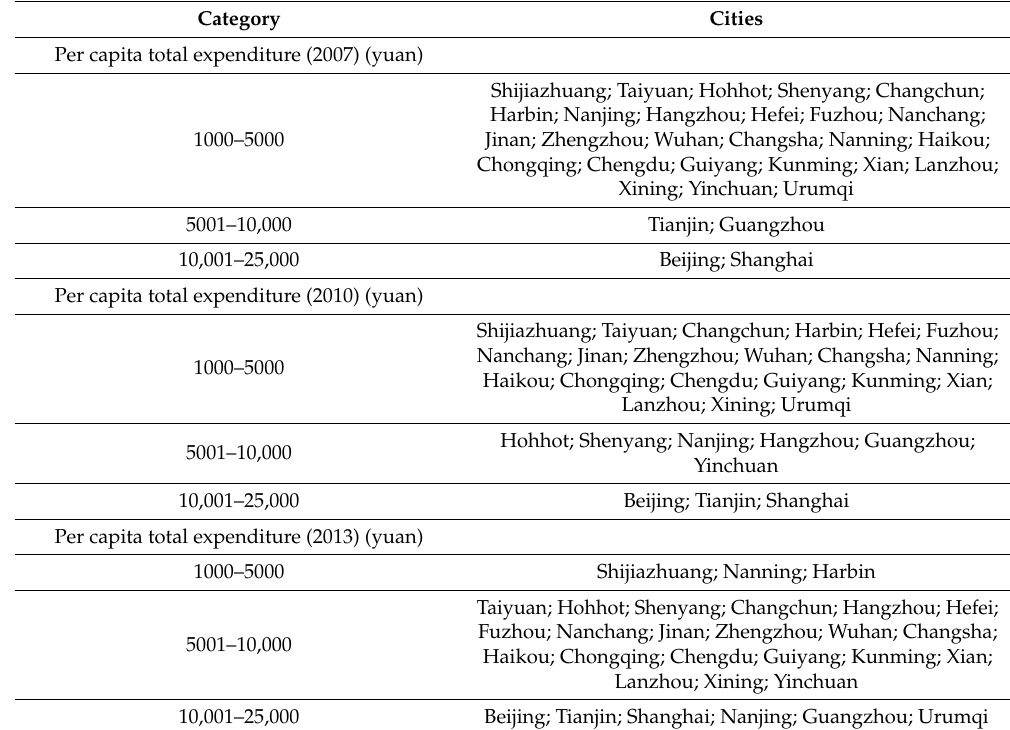
Table 5. Urban public services expenditure per capita.